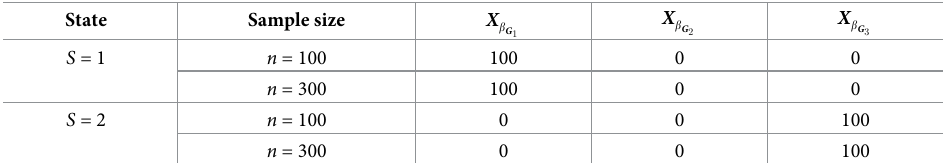
Table 3. Frequency of group variables selected in